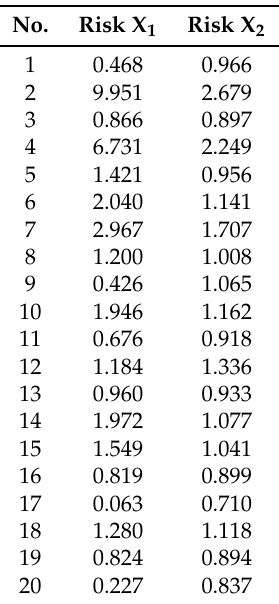
Table 1. The original data.